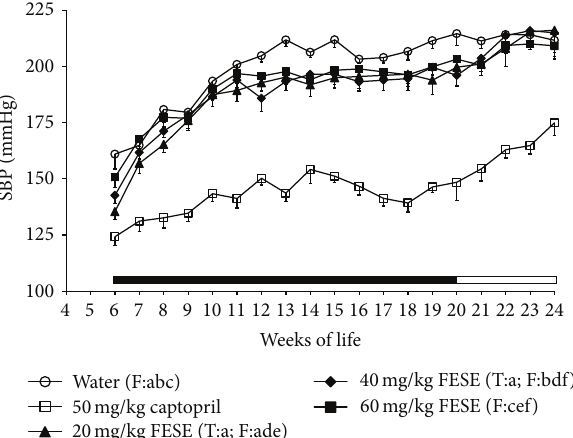
Figure 1: Systolic blood pressure (SBP) of spontaneously hyper- tensive rats. The animals drank different fluids from weaning until the 20th week of life (treatment period = T, indicated by a solid bar) and received therefore different daily treatments: tap water, 20 mg/kg/day Fraxinus excelsior L. seed extract (FESE), 40 mg/kg/day FESE, 60mg/kg/day FESE, or 50mg/kg/day captopril. Allratsdranktapwaterfromthe20thweekoflifeuntilthe24thweek of life (follow-up period = F, indicated by an open bar). Data are meanvalues ± SEMfor10animalsinTandfor5animalsinF.Similar letters represent no statistical differences ( 𝑃 > 0.05 ). 𝑃 estimated by two-way